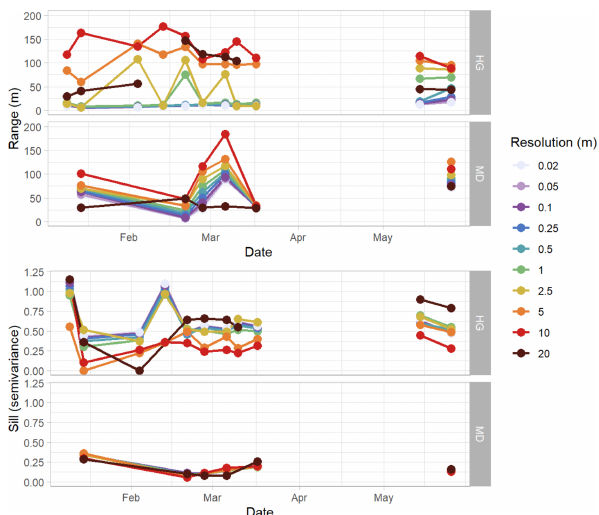
Figure 6. Relative range and sill patterns of spherical-fit vari- ogram models of detrended snow depth residuals using the nearest- neighbor resampling method in the Hourglass (HG) and meadow (MD) throughout the winter. Colors represent different snow depth digital surface model (DSM) resolutions. The range plot excludes the 20m range values from the Hourglass for 13 February 2020 and 17 March 2020, which are greater than